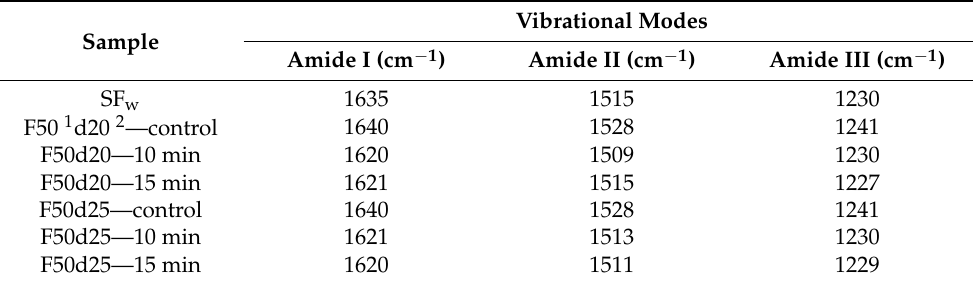
Table 1. Wavenumbers for the main amide vibrational modes of the pristine SF w spectra, electrospun membranes without and with methanol treatment for 10 min and 15 min.